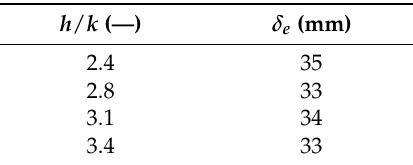
Table 3. Penetration